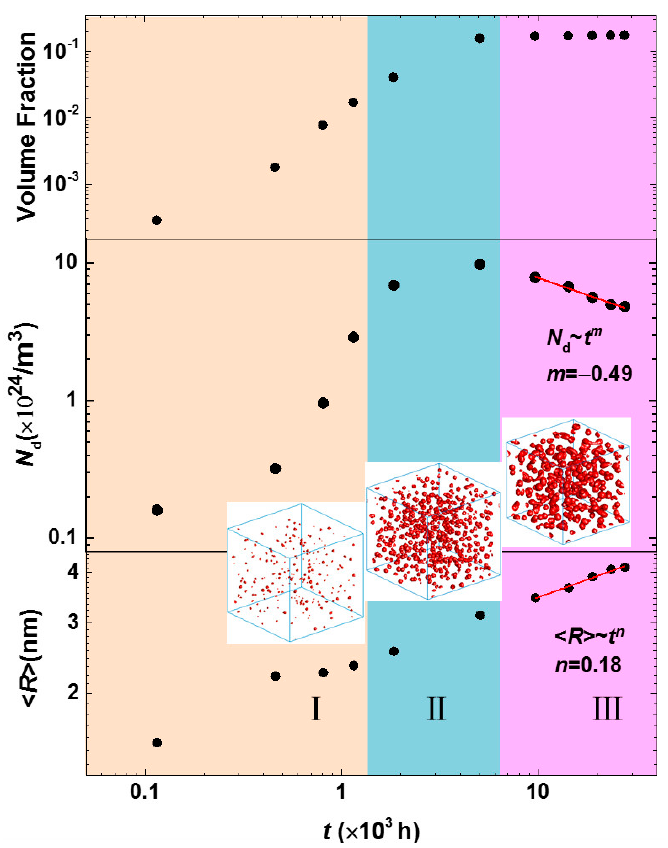
Figure 6. The temporal evolution of the volume fraction, particle number density and the average particle radius of the Cr-enriched α′ phase in the Fe-30 at % Cr alloy aged at 750 K. Table 1. Coarsening rate constants k and time exponents for the average radius and particle number density of the α′ phase in Fe-Cr alloys aged at 750 K.